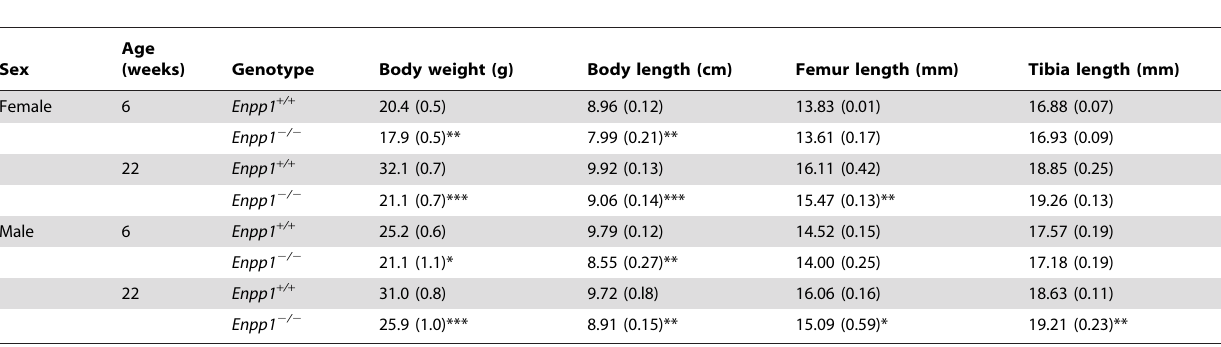
Table 1. Body weight, body length and long bone length taken at 6 week and 22 weeks of age from male and female and Enpp1 2 / 2 and wild-type